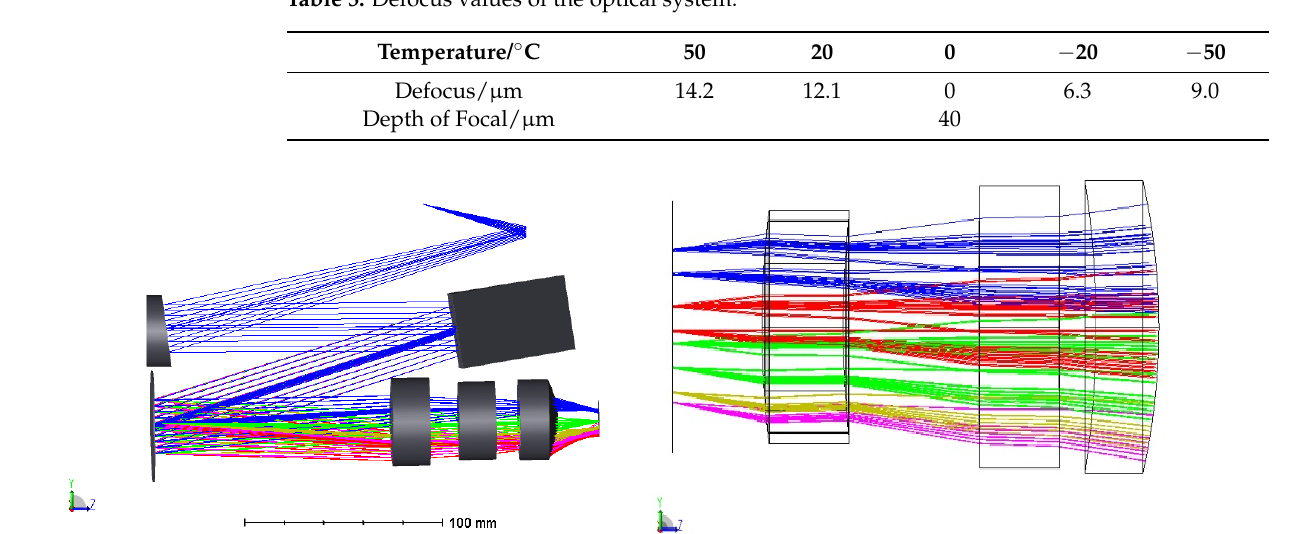
Figure 17. Optical layout of MIR-cooled spectrometer. Figure 16. Optical layout of MIR-cooled spectrometer.